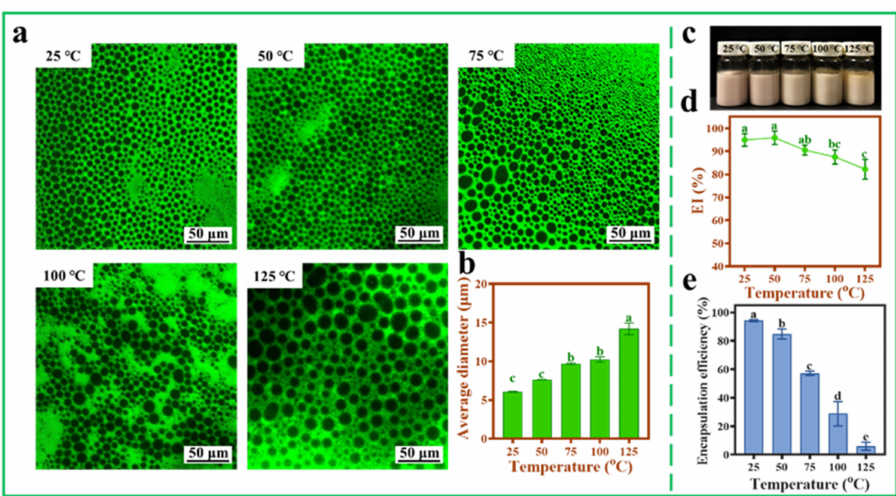
Figure 8. Inverted fluorescence microscopy images ( a ), average diameter ( b ), photograph ( c ), EI% ( d ), and EE% ( e ) of AXT-loaded Pickering emulsions at different temperatures (25, 50, 75, 100, and 125 ◦ C, pH = 4, ω (NaCl) = 0, ω (TOCNFs) = 0.9 wt%, 450 W). Different letters of a, b, c, d and e show